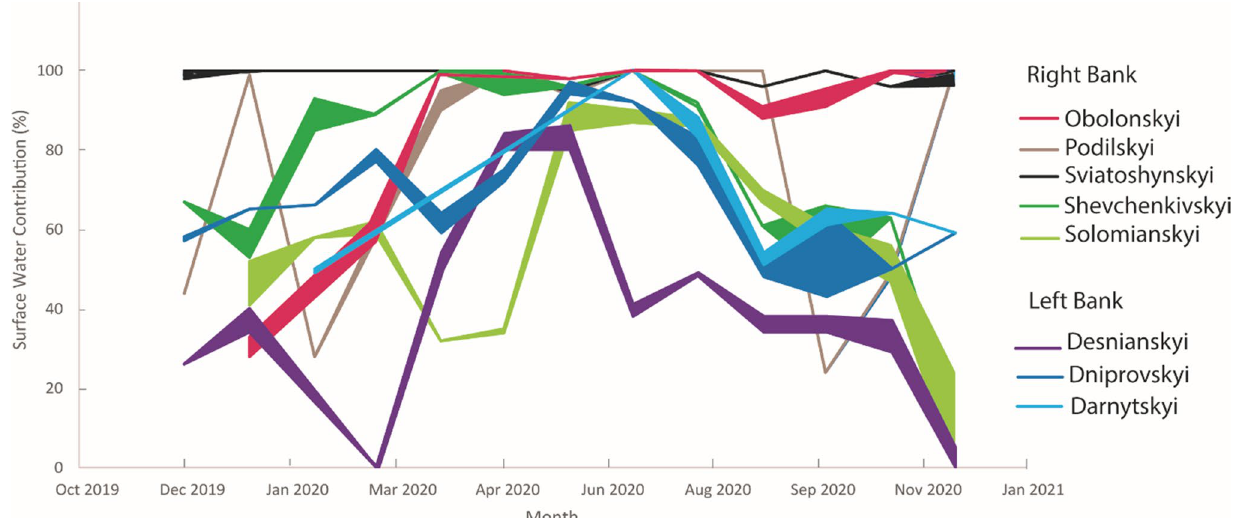
Fig. 4 Percent range of surface water contribution to tap water each month by district. The width of the line represents the range of pos- sible contribution percentages given by IsoSource (for instance, a wider line represents a larger range of possible contribution percentages, while a thin line represents fewer